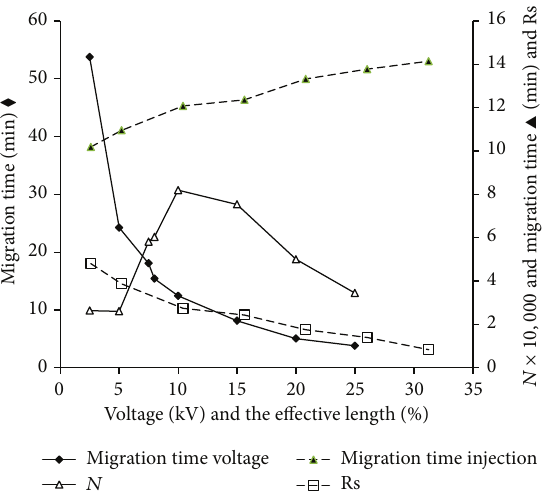
Figure 4: Influences of injection volume on migration times and Rs, effects of voltages on stacking.